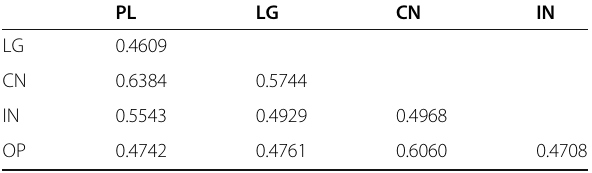
Table 2 Beta diversity ( β ) of bird communities ’ similarity at landscape level across dam development phases in Puah Lake Catchment, Hulu Terengganu, Peninsular Malaysia. The highervalue means the more dissimilarity of one phase to its paired phase. Abbreviations: PL pre-log, LG logging, CN construction, IN inundation, OP operation PL LG CN IN LG 0.4609 CN 0.6384 0.5744